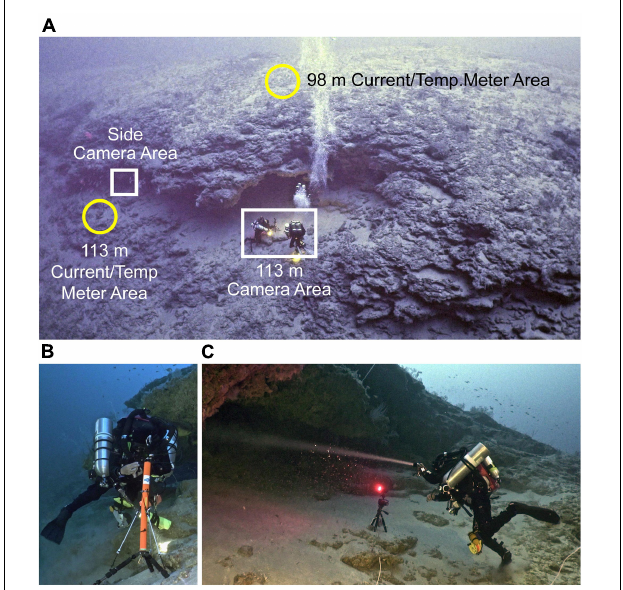
FIGURE 2 | Photographs of the cave overhang area (A) where current meters and temperature recorders (B) were set at 98 and 133 m, and camera systems (C) were placed in front and to the side (also see Supplementary Figures 4, 5A,B ) of the opening of the cavern. The cameras and meters were set on the bottom by divers using a tri-mix gas system (B,C) . The camera in (C) is shown with its light on, but for the observation period that camera was set to have its light off. North is approximately in the right direction in (A)